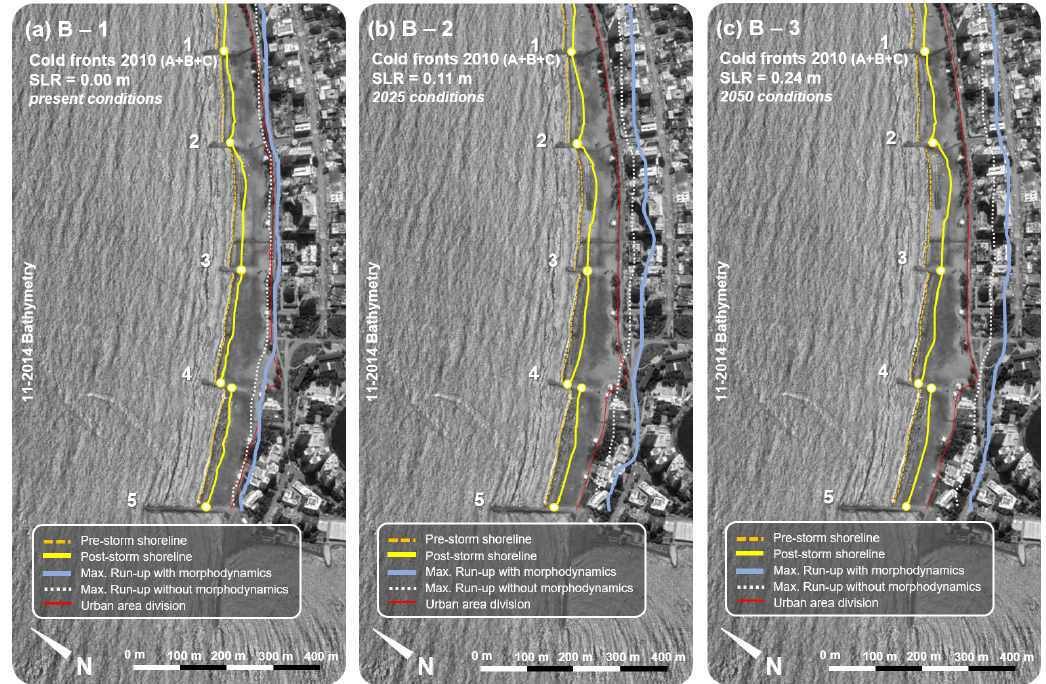
Figure 4. Maximum flood range (with and without morphodynamics) and post-storm shorelines simulated by XBeach for 2010 cold front succession with different SLR conditions. Map base images retrieved from © Google Earth and modified by the